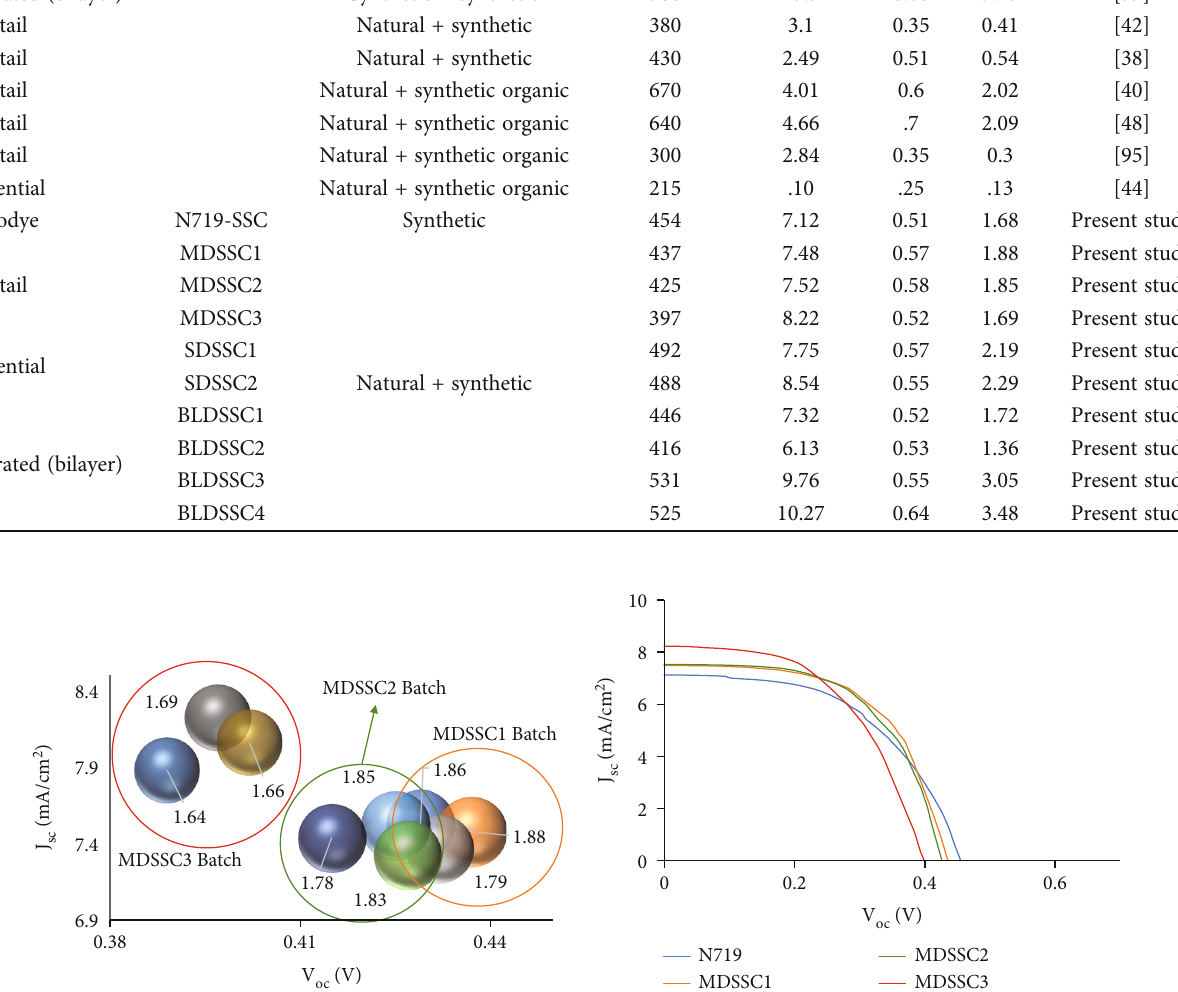
ffi ciencies); (b) the J - V